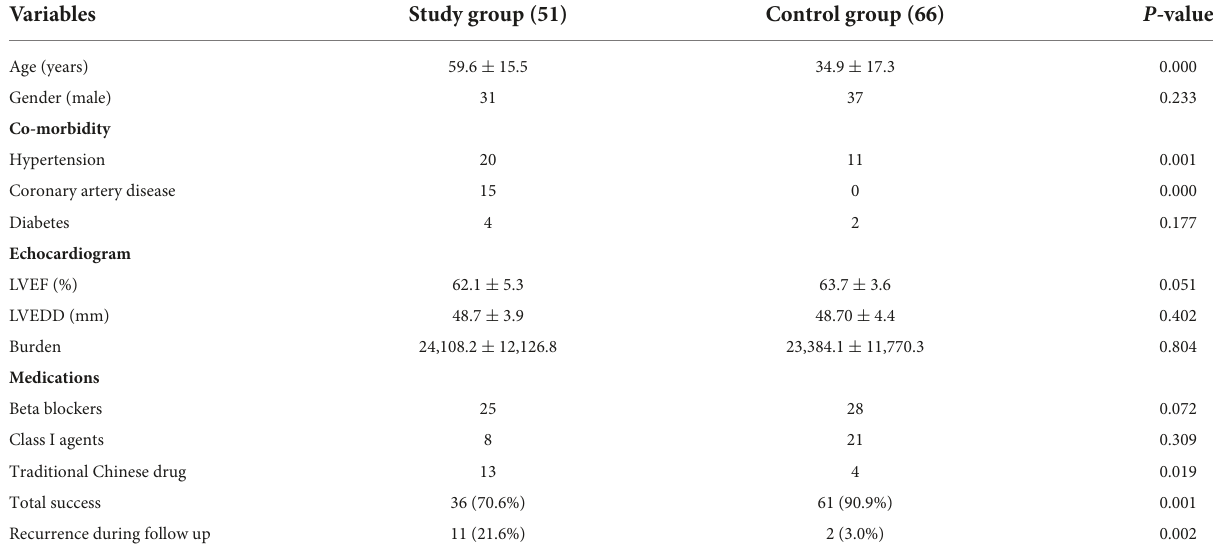
TABLE 1 Comparisons of clinical and electrophysiological characteristics of VAs in basal septum (studied group) and other area of tricuspid annulus and mitral annulus (control group).